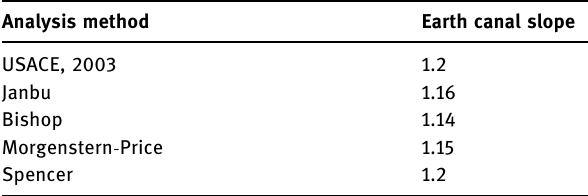
Table 5: A minimum FOS in rapid drawdown Analysis method